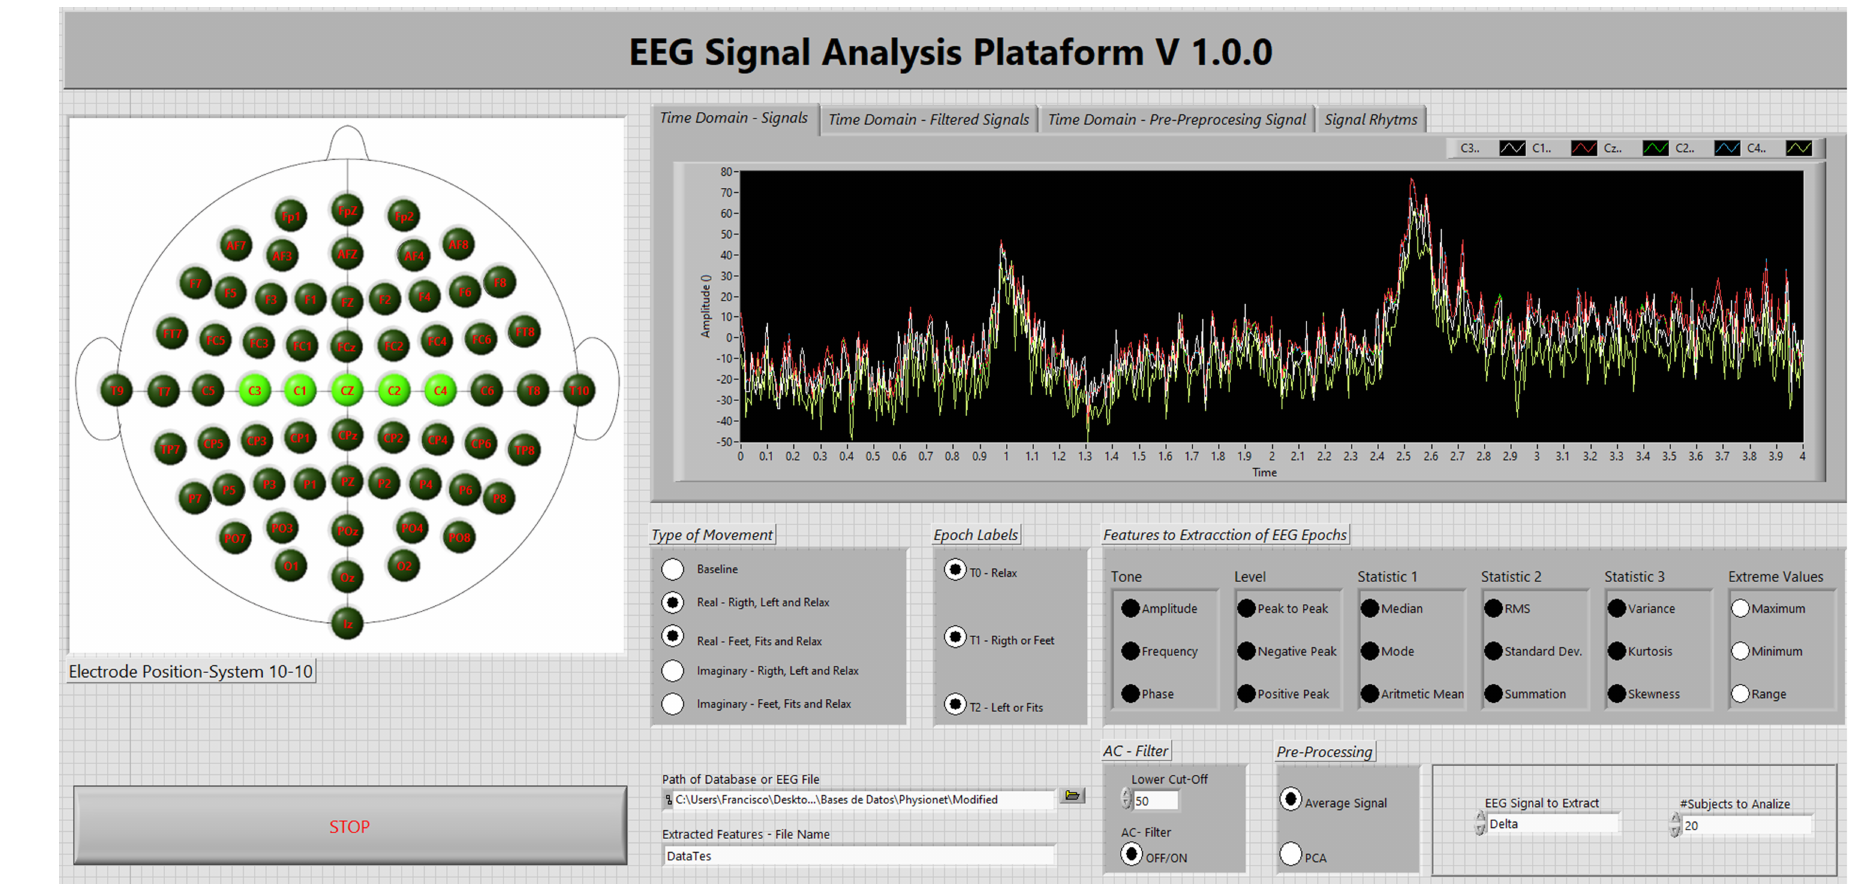
Figure A2. Front panel of software (App) developed for EEG signal